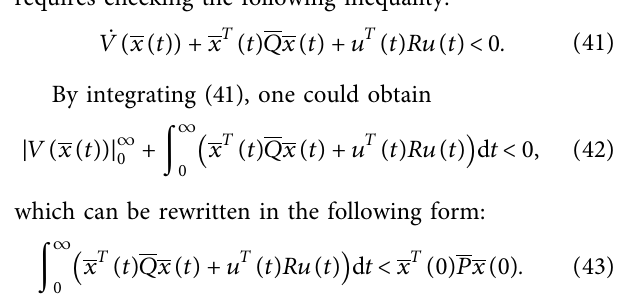
Figure 4: Wind speed